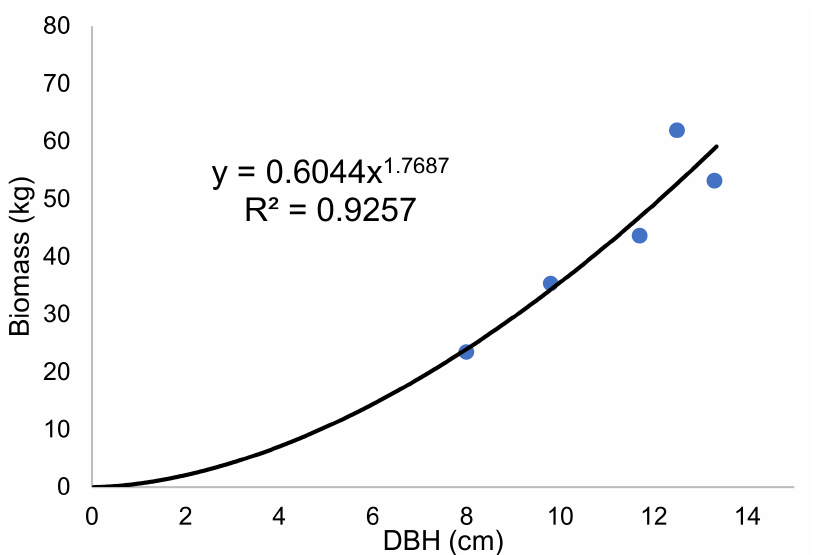
Figure 3. In situ allometric equation derived as the relationship between total dry biomass and diameter at breast height (DBH) of five model